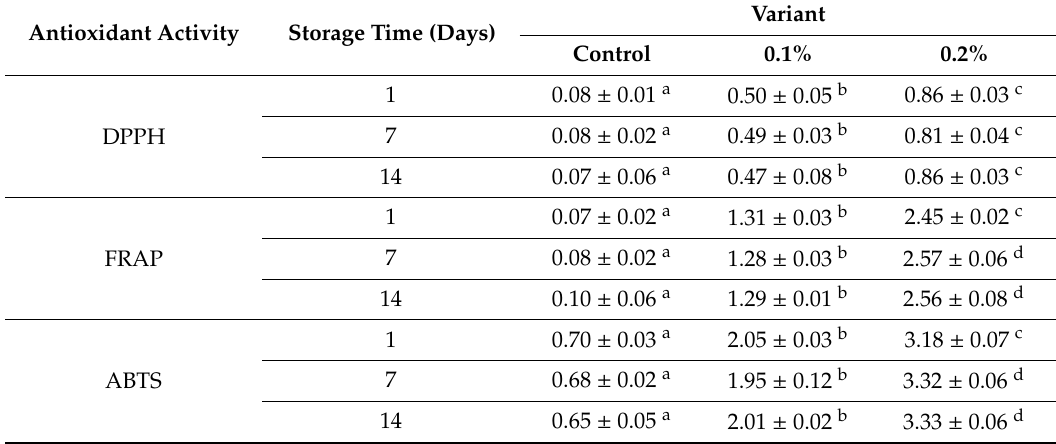
Table 5. Antioxidant activity DPPH, FRAP and ABTS (mM Trolox / L) in yoghurts with addition of 0.1% and 0.2% of Rosa spinosissima fruits